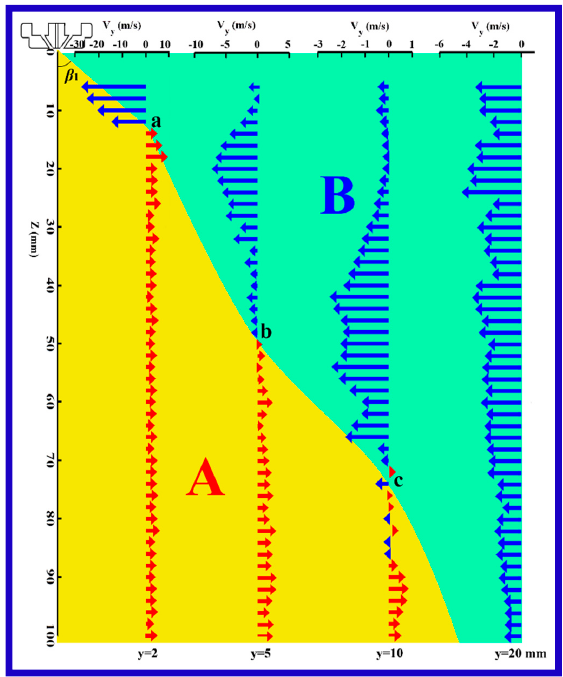
Figure 9. The distribution of lateral velocity, v y , along lines 1–4 of y = 2, 5, 10, and 20 mm, in the corresponding y–z plane. A represents the lateral diffusion region, B represents the lateral back-diffusion region.